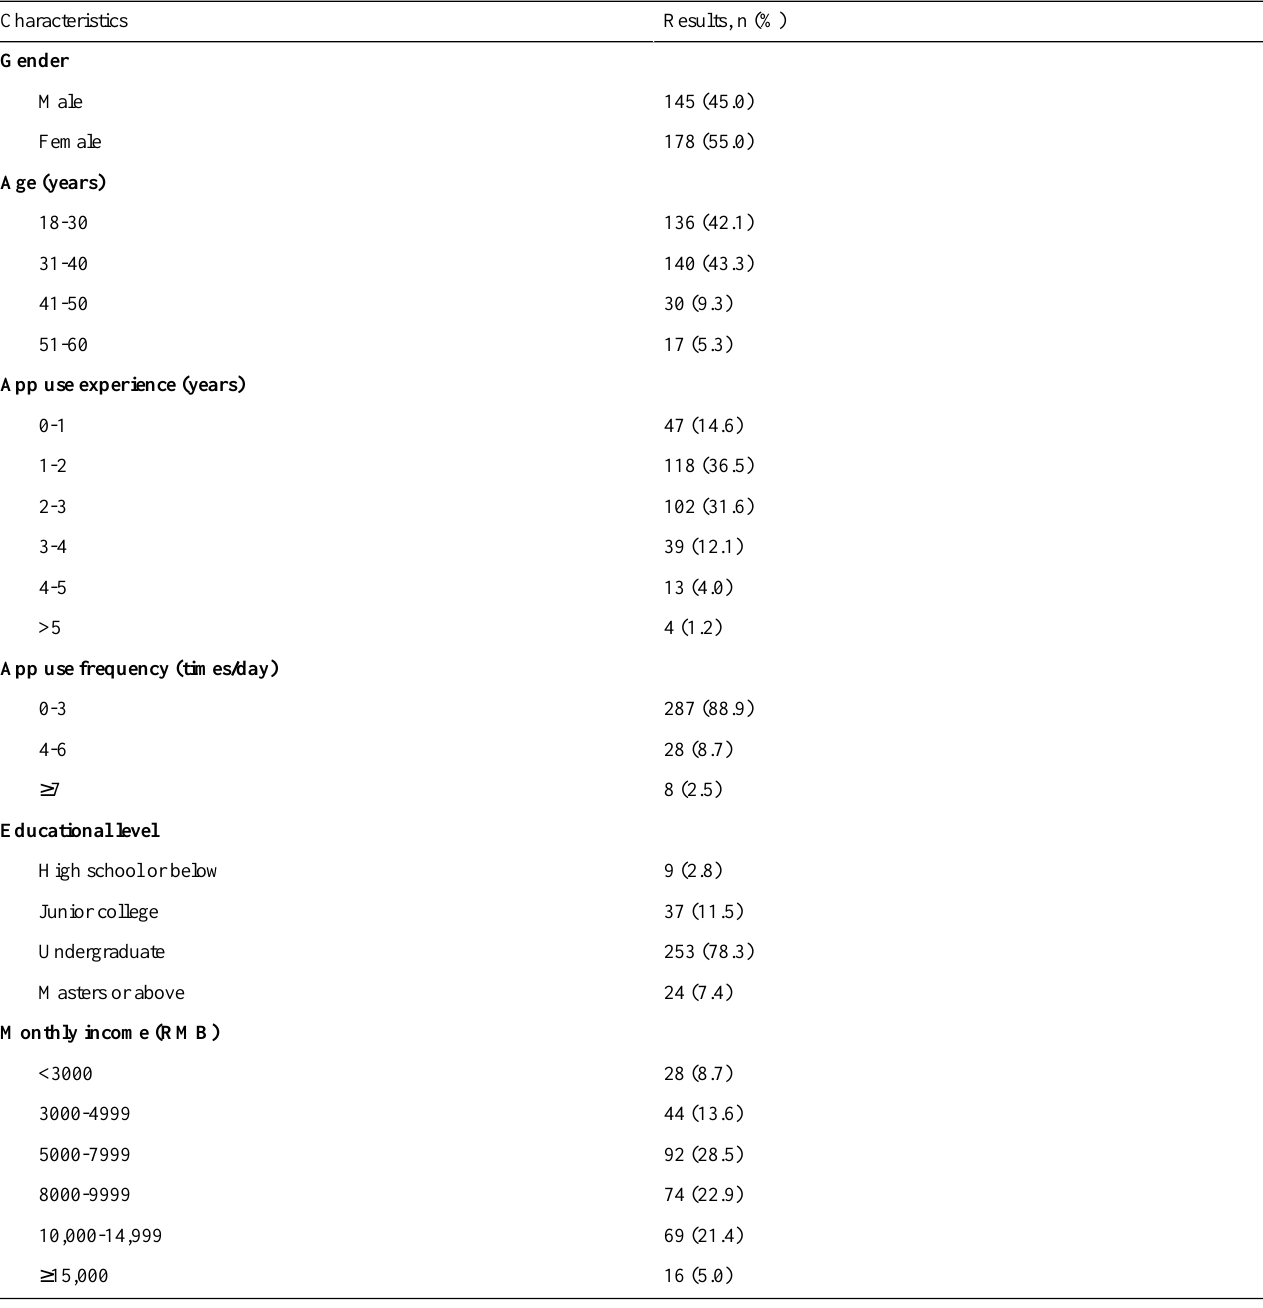
Table 2. Demographic characteristics